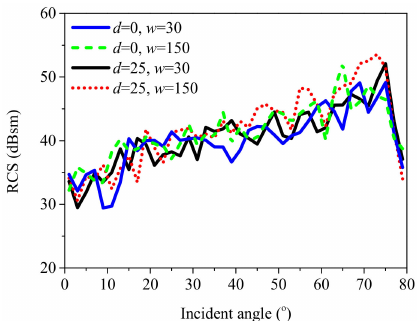
Figure 11. Comparison of the coupling scattering field in the yoz plane for di ff erent distances.